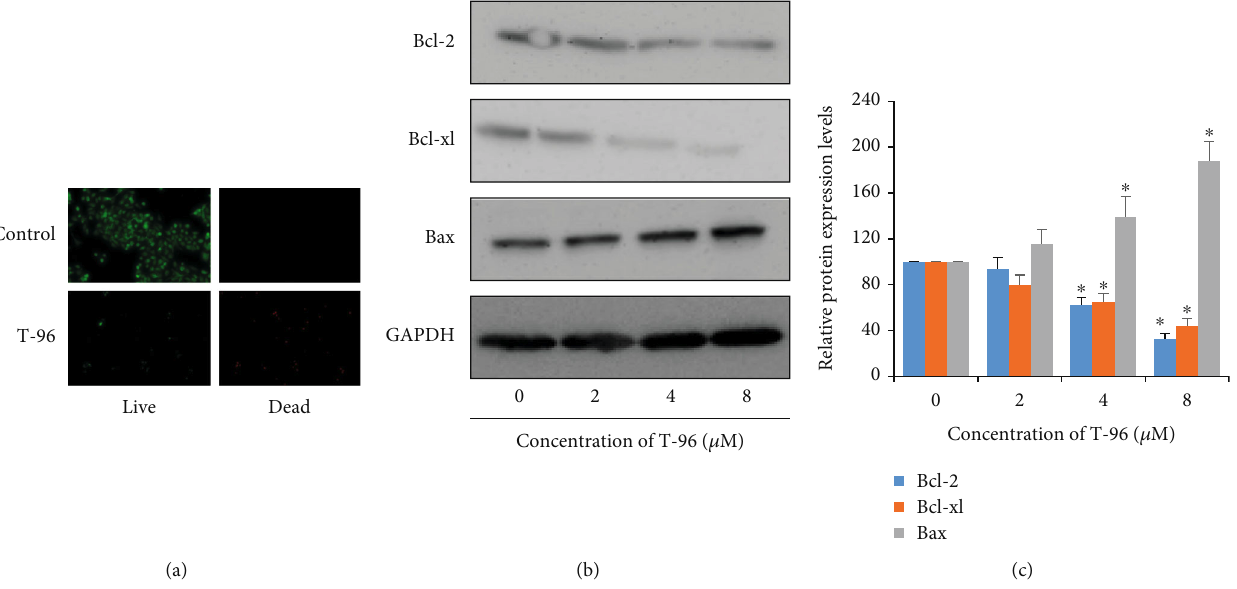
Figure 2: T-96 induced apoptosis in the highly metastatic breast cancer cell SUM-1315. (a) Analysis of the dead and live cell by LIVE/ DEAD ™ Viability; (b) and (c) Western blot was used to measure Bcl-2, Bcl-xl, and Bax protein expressions. Values are statistically signi fi cant at ∗ P < 0 : 05